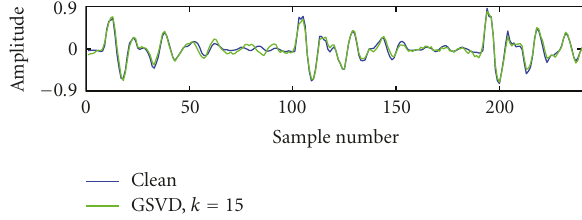
Figure 8: Comparison of the clean signal and the GSVD-based MV estimate for k =